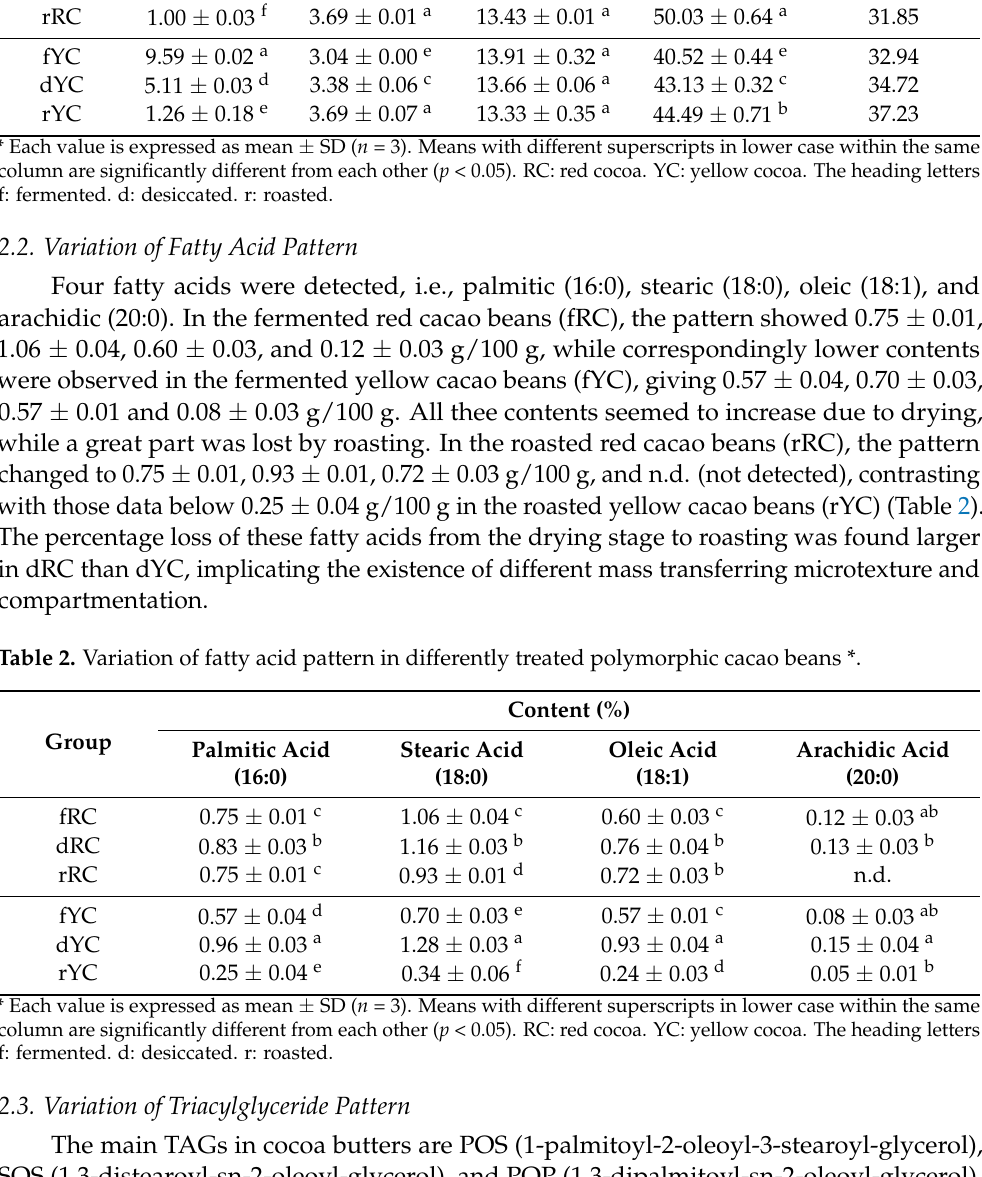
Table 1. Variation of proximate composition in differently treated polymorphic cacao beans *. Content (%) Group Moisture Crude Ash Crude Protein Crude Fat Carbohydrate fRC